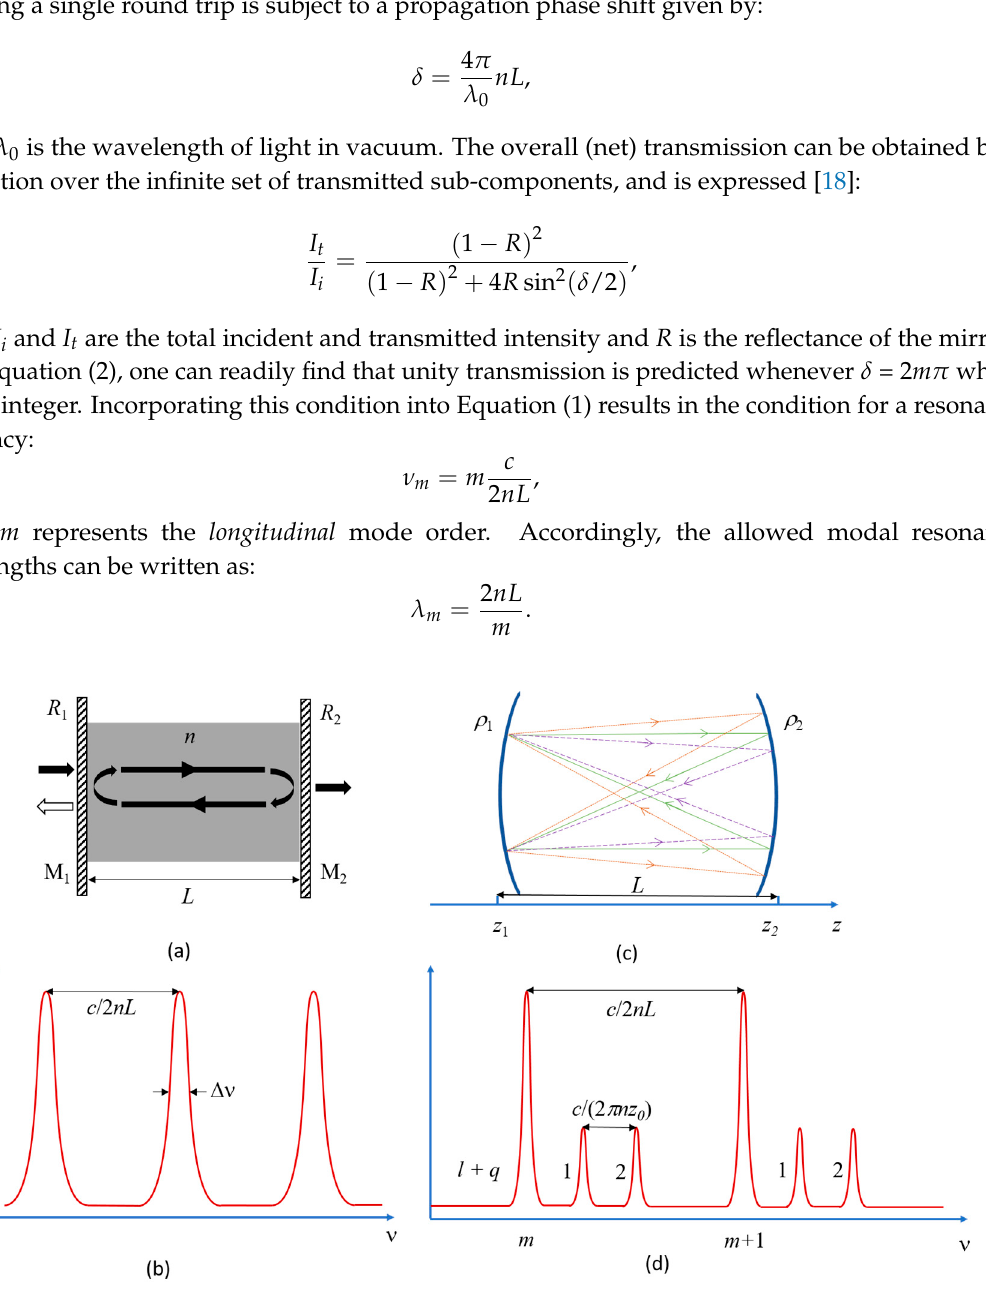
Figure 1. ( a ) Schematic of a Fabry-Perot resonator consisting of parallel mirrors M 1 and M 2 with reflectances of R 1 and R 2 , respectively, surrounding a cavity medium of refractive index n and thickness L . Light introduced from one side undergoes multiple reflections, leading to partial transmission from the other side; ( b ) Typical transmission of a planar FPC depicting frequency spacing (i.e., the FSR) of adjacent longitudinal modes and the full-width at half-maximum ( Δ ν ) of an individual modal peak; ( c ) Schematic representation of a curved-mirror FPC with length L, where mirrors with radii of curvature ρ 1 and ρ 2 are placed at z 1 and z 2 , respectively; ( d ) Typical transmission spectrum of a curved-mirror FPC as a function of mode numbers l , q , and m , where ρ 1 , ρ 2 >> L is assumed .